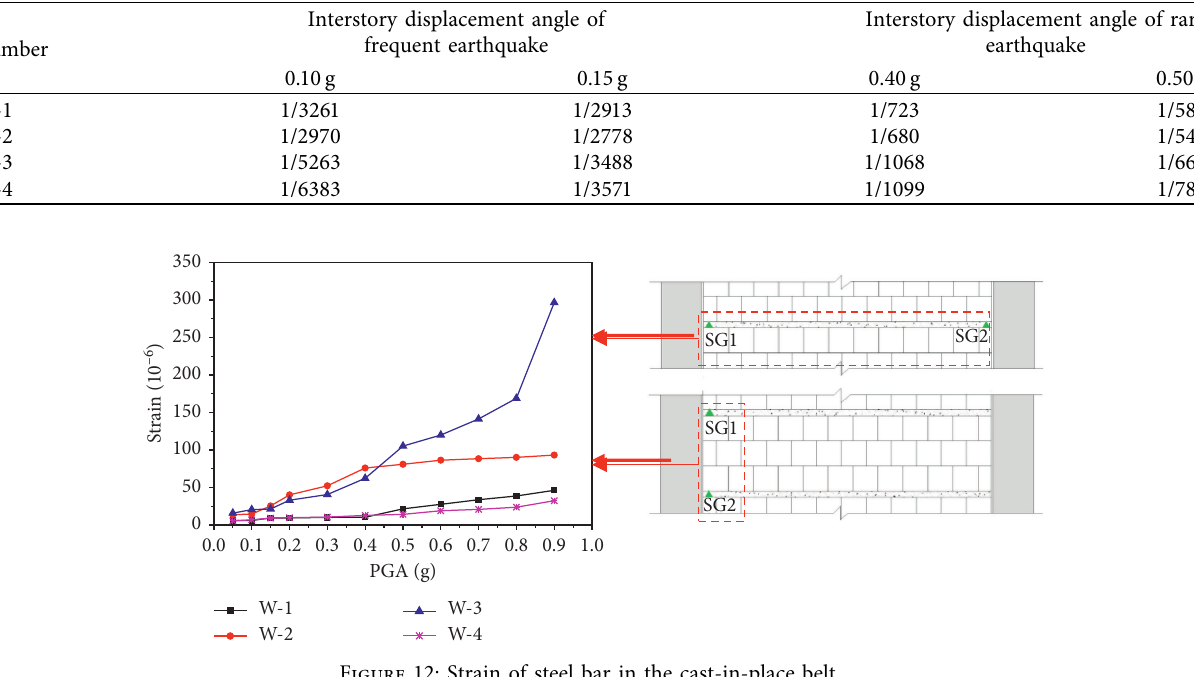
Figure 11: Relative displacement of the wall. (a) In the middle of the wall. (b) At the top of the wall. Table 6: Interstory displacement angle.